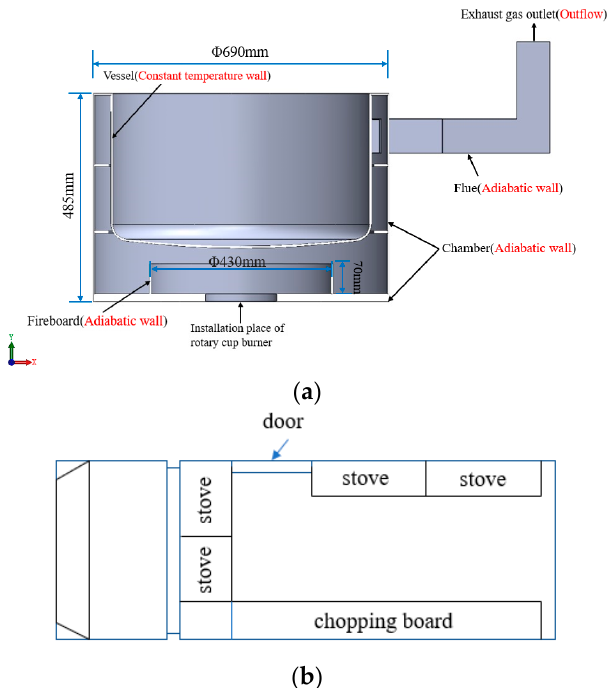
Figure 1. Schematic diagram of stove A’s combustion chamber: ( a ) 3D model and boundary condi- tions; ( b ) stove’s localization in the vehicle.